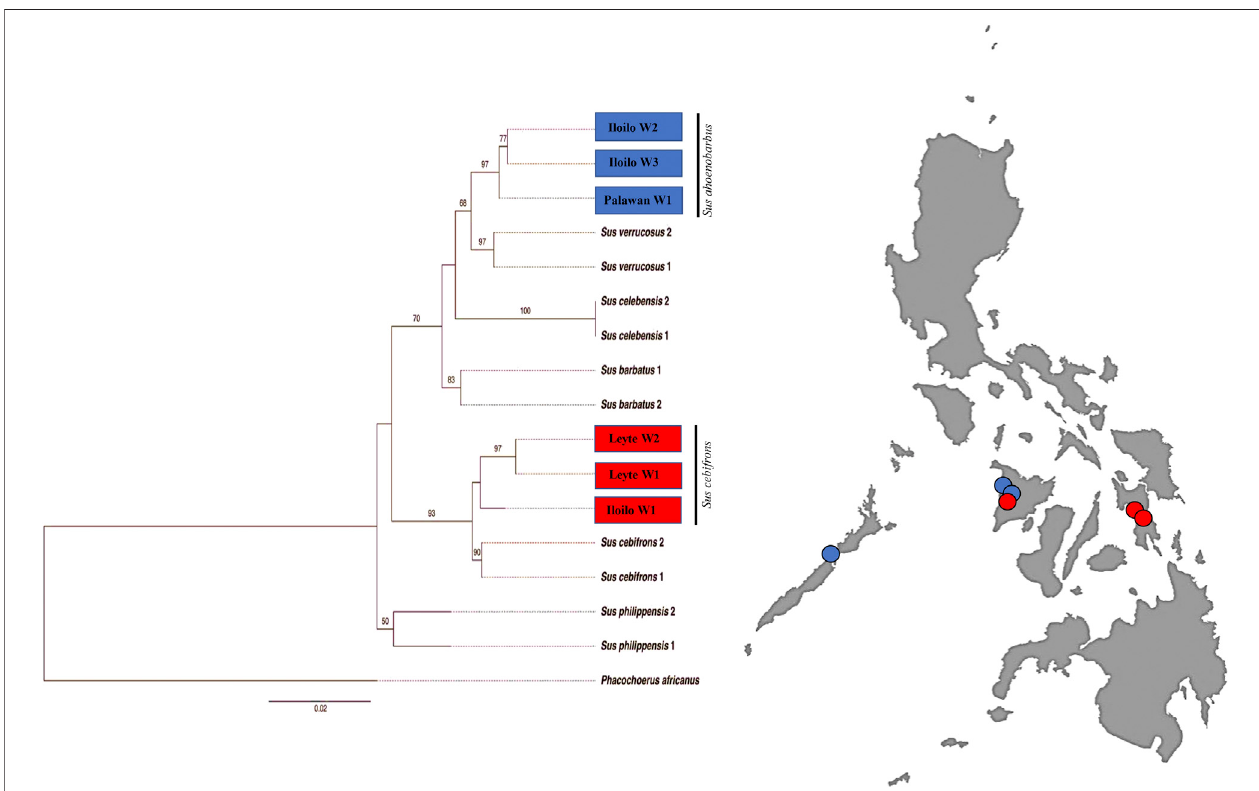
FIGURE4| Maximum Likelihood (ML) inference ofPhilippine wild pigsincluding theavailable mtDNA D-loop sequences ofwildpigs from theGenBankwithGTR+ G as the best- fi tted model using PhyML ver.3.0 with Warthog ( Phacochoerus africanus ) as outgroup.